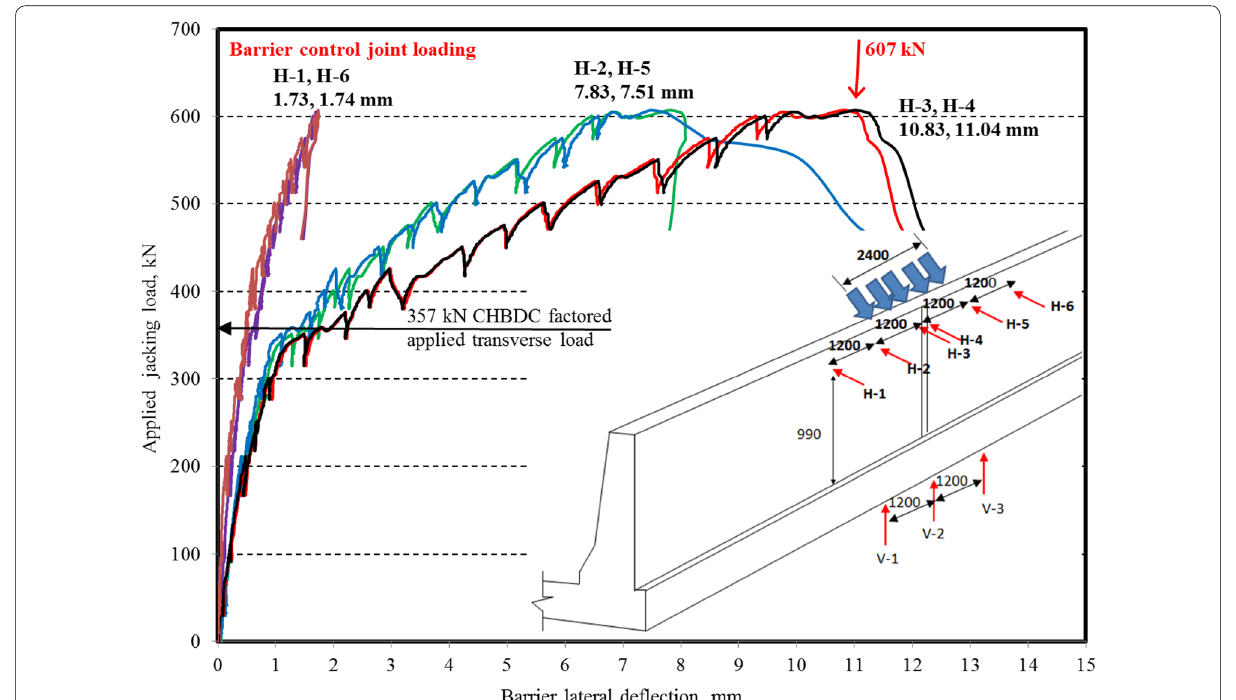
Fig. 10 Load-deflection relationship for barrier segment loaded at control